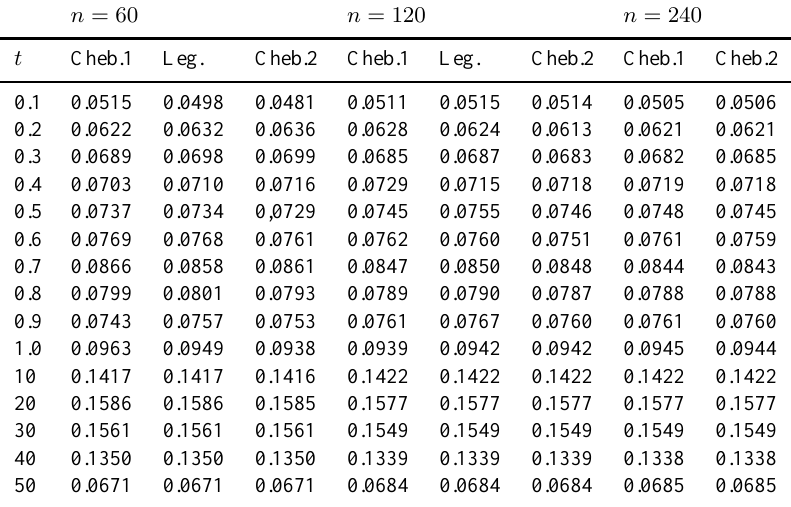
Table 2. Values of j u ( x; t ) j obtained by the DM method with the Chebyshev and Legendre nodes for x = L = 15 ; (cid:13) = 2 and (cid:14) ( x ) = tanh(7 x (cid:0) 3 : 5 L ) : n = 60 n = 120 n =